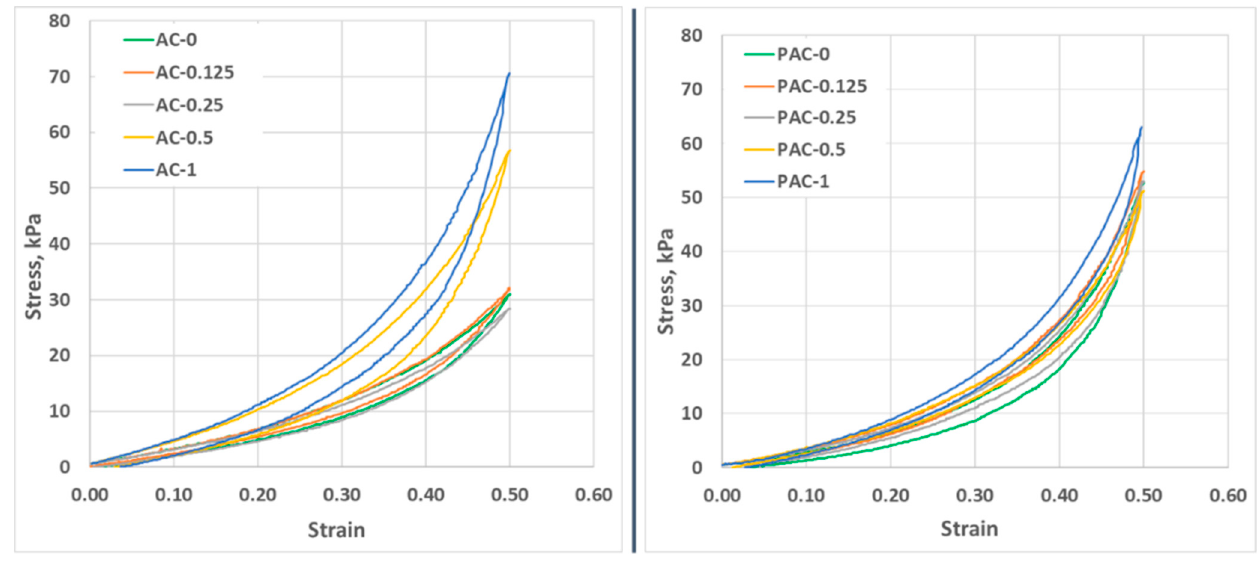
Figure 5. First cycle of loading–unloading compressions for the AC ( left ) and PAC ( right ) series. Table 3. Mechanical parameters of the AC and PAC hydrogels.